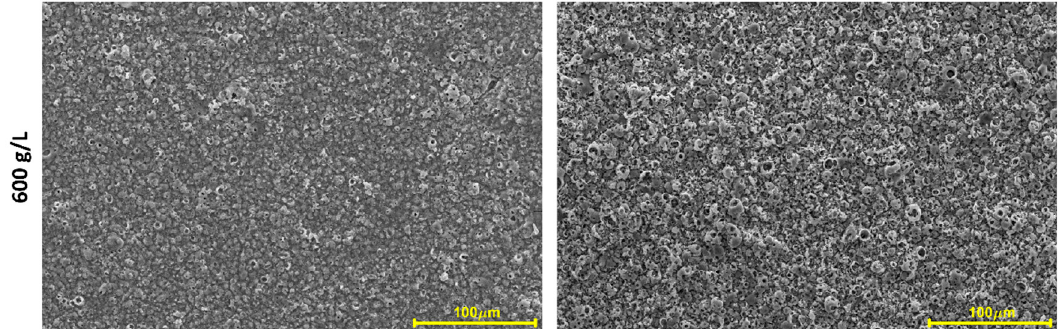
Figure 1. SEM micrographs of samples surfaces after PEO processing obtained in electrolytes composed of Mg(NO 3 ) 2 ·6H 2 O and Zn(NO 3 ) 2 ·6H 2 O in H 3 PO 4 in three concentrations 10 g/L, 300 g/L, and 600 g/L, at a voltage of 450 ± 46 V, with a pulsation frequency of 300 Hz. Magnification 1000 times.